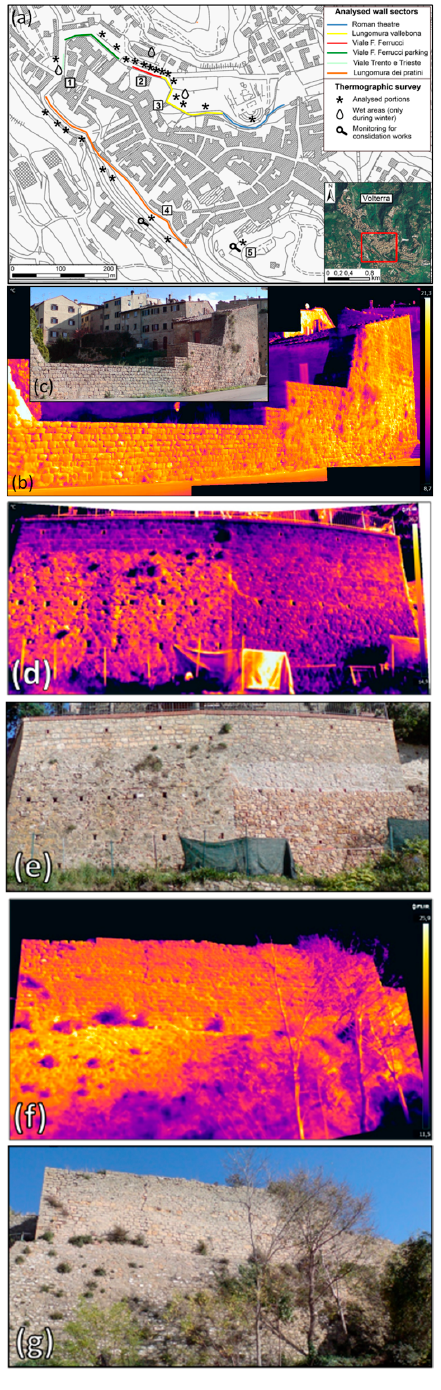
Figure 9. ( a ) Thermographic conservation criticality map of the Volterra city wall enclosure; labels from 1 to 5 represent the thermograms shown in the Pratini ( b , c ), from NW to SE along Viale Trento e Trieste ( d – g ).